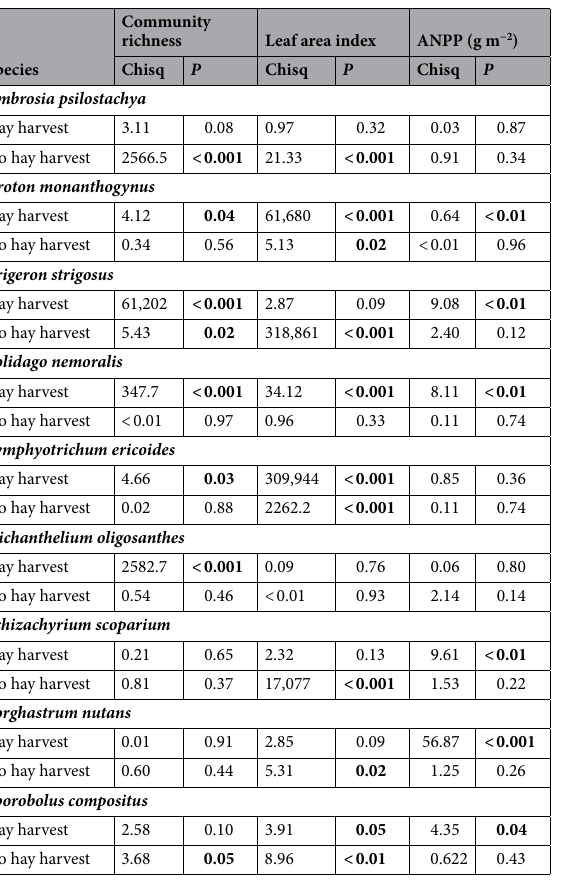
Table 1. GLMM of main effects of plant richness, leaf area index and ANPP on focal species height , under hay harvest vs. no hay harvest across the precipitation gradient. Significant P (≤ 0.05) shown in